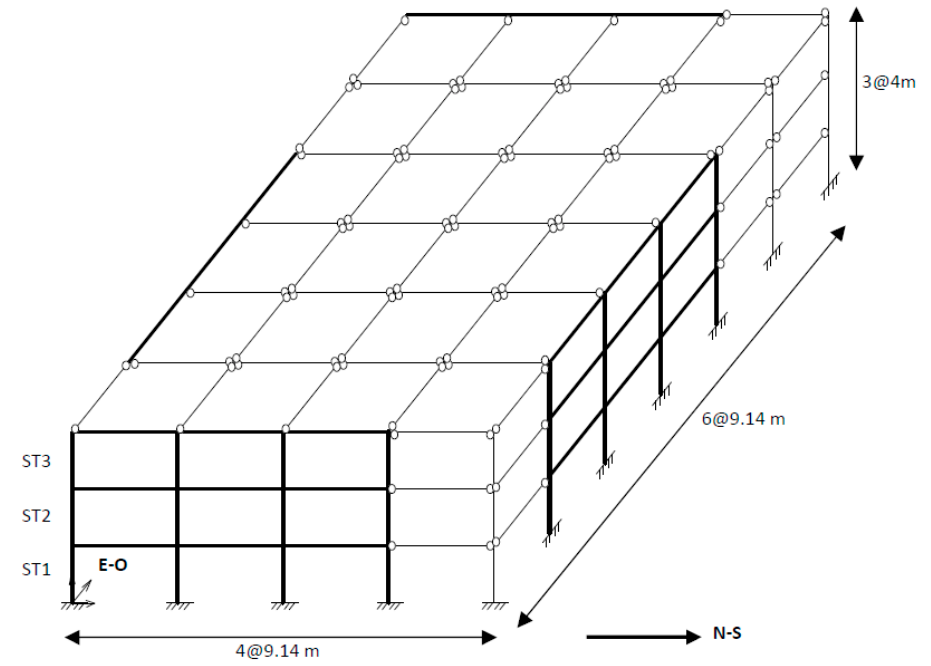
Figure 1. Isometric view of the 3 ‐ level building. Table 1. Beam and columns sections for Models 1 and 2.